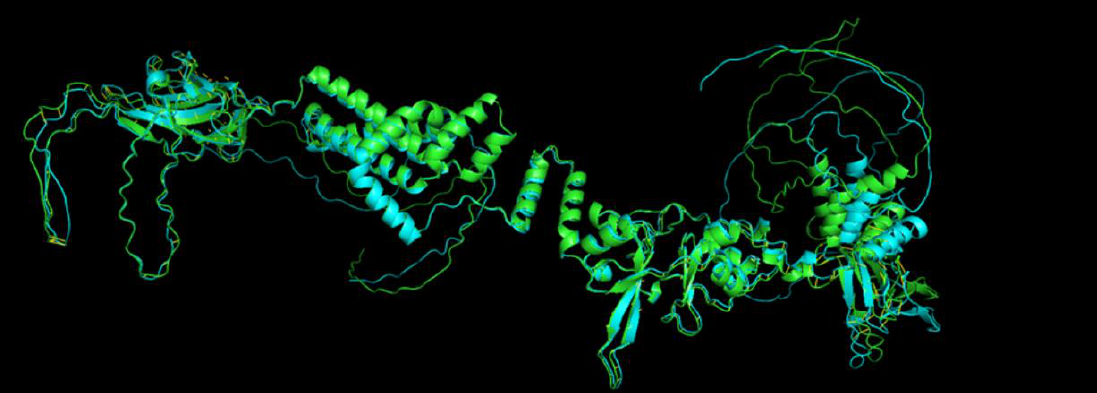
Figure 3. The p.Pro482Ala alteration causes a conformational change in CNNM2 structure in the CBS domain and the carboxy-terminal protein segment, which may affect ATP-Mg 2+ complex binding to the protein. Mutated protein with blue color and normal protein with green color (protein structure prediction databank Alpha fold-2 [13]).